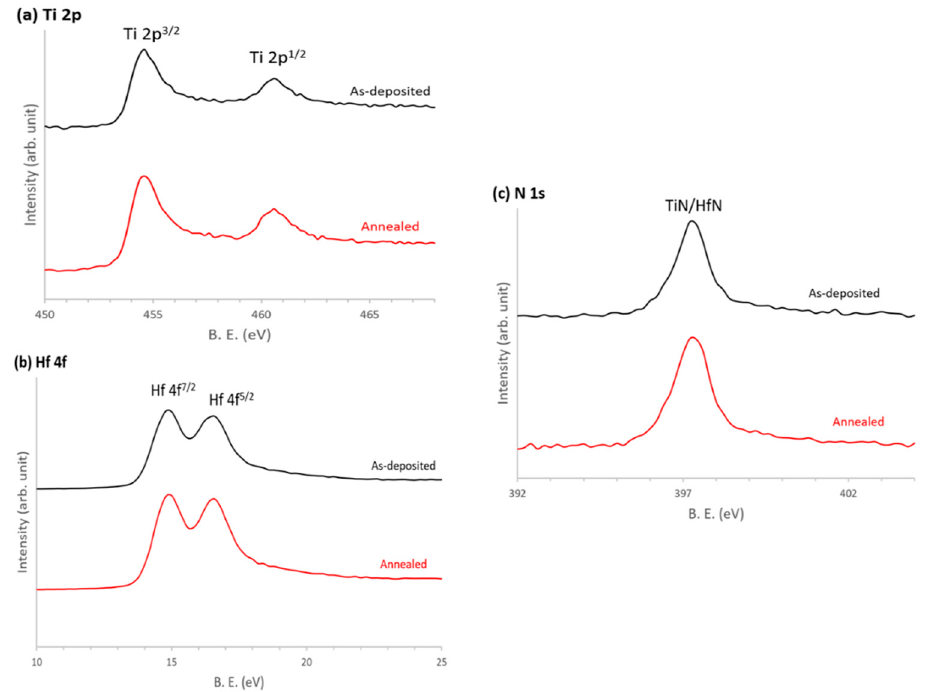
Figure 5. XPS spectra of the as-deposited and annealed TiHfN/Si samples. ( a ) Ti 2p, ( b ) Hf 4f and ( c ) N 1s.